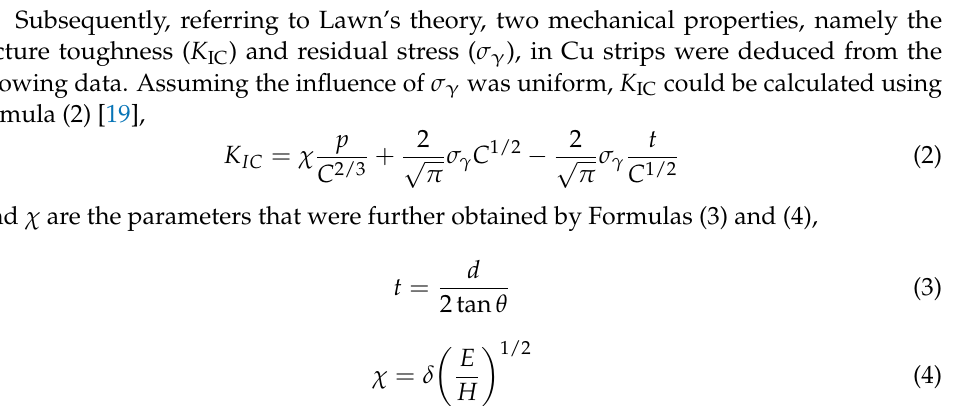
Figure 2. Principle of the Vickers indentation methods.